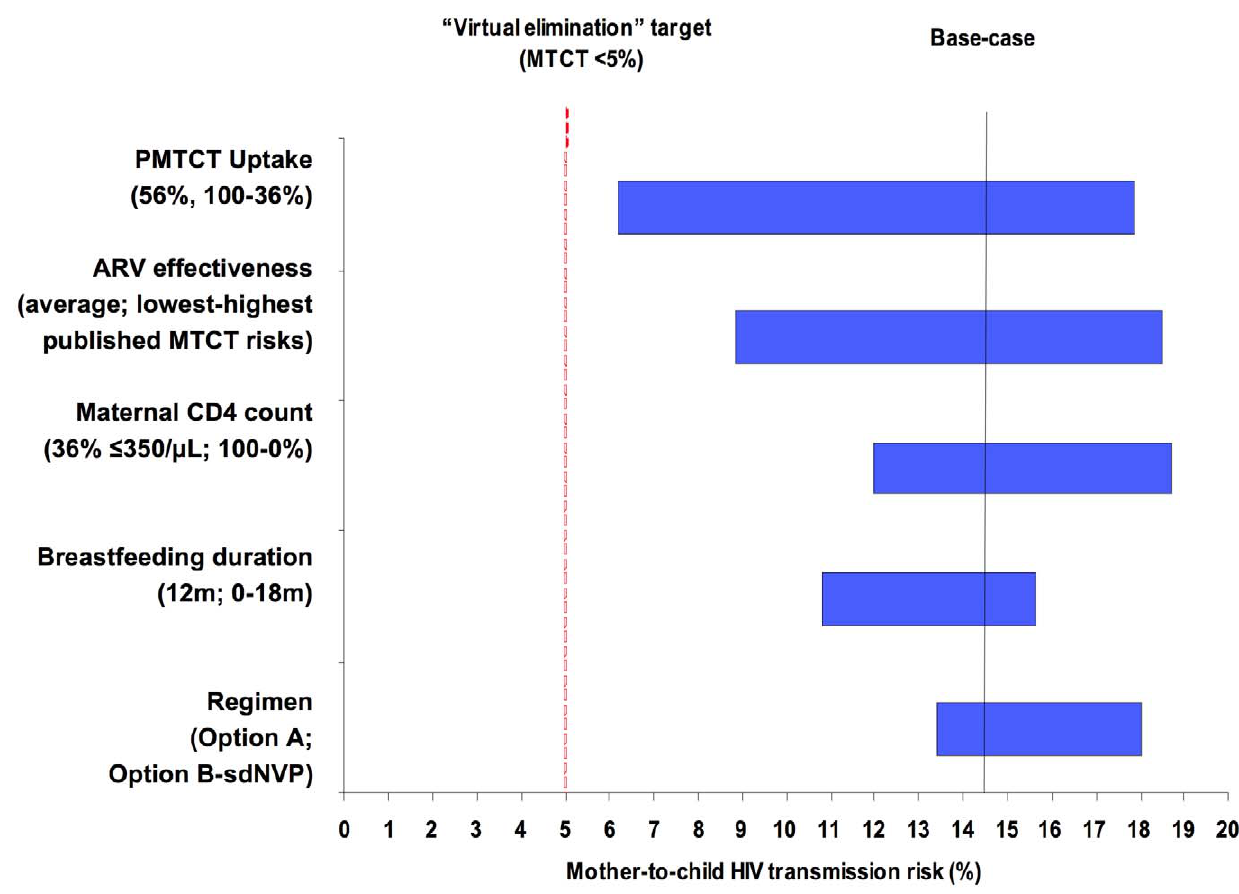
Figure 2. Key parameters determining MTCT risk. Tornado diagram summarizing the results of key one-way sensitivity analyses. Model parameters are on the vertical axis. For each parameter, the value used in the base-case analysis is listed in parentheses, followed by the range examined in sensitivity analysis. For example, the ‘‘regimen’’ provided for PMTCT is varied from Option B (lowest MTCT risk with all other parameters held constant), through Option A (base-case MTCT risk), to sdNVP (highest MTCT risk). The horizontal axis represents projected MTCT risk by the time of weaning. The solid vertical line represents transmission risk (14.4%) at the base-case set of parameters: 56% uptake, mean published MTCT risks, 36% of mothers with CD4 , 350/ m l, breastfeeding duration of 12 mo, and the WHO ‘‘Option A’’ regimen. The dashed vertical line represents the 5% MTCT target of ‘‘virtual elimination’’ expressed by international HIV/AIDS agencies including WHO and the Joint United Nations Programme on HIV/ AIDS. ARV prophylaxis in the Option A and Option B regimens is assumed to continue throughout the duration of breastfeeding.